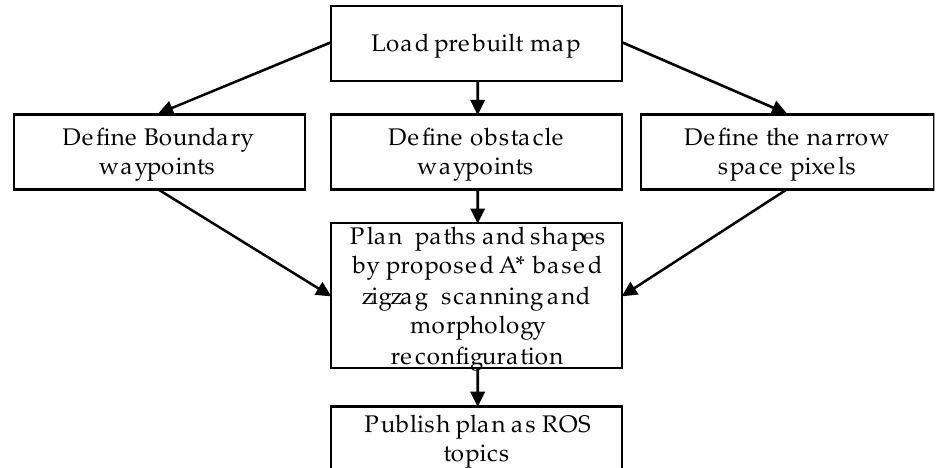
Figure 10. Global path and shape planner flowchart.